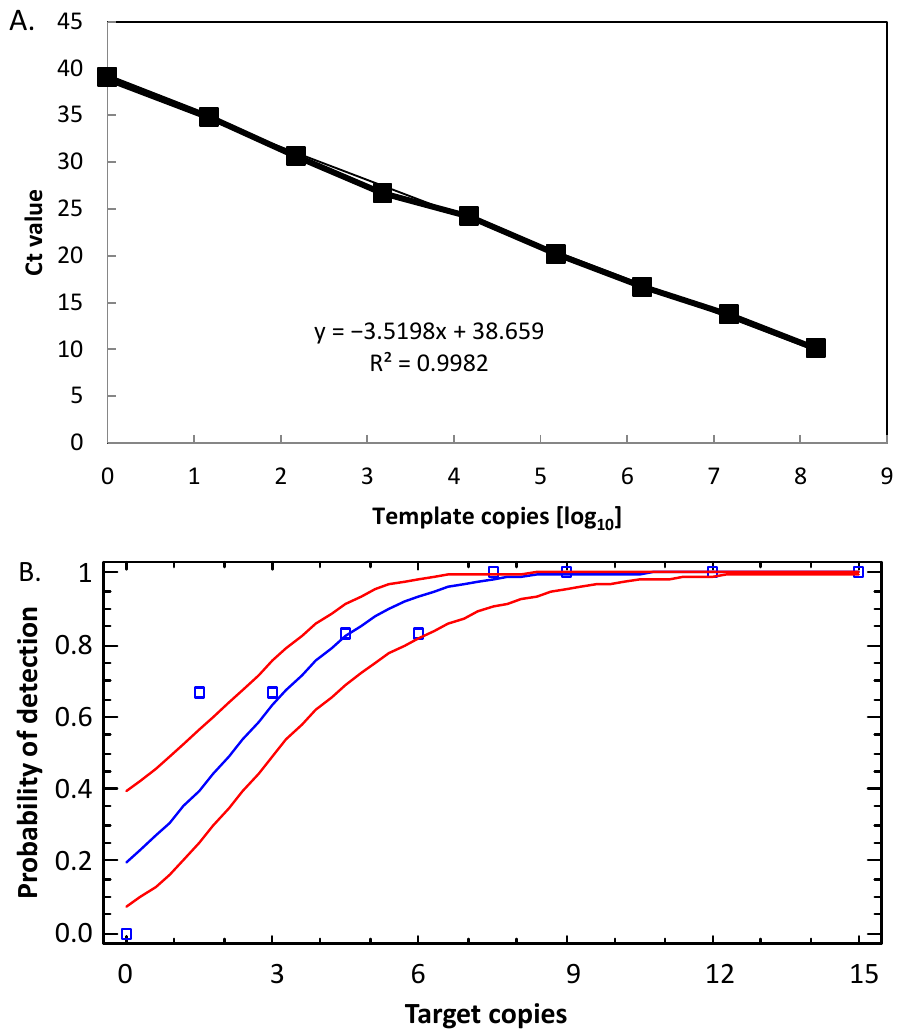
Figure 5. Linearity and LoD of the 16S rRNA SNP RT-PCR. Serial dilutions of RNA (with DNA) of B. anthracis strain Sterne were serially diluted 1:10, RT-PCR-tested and template copies plotted against Ct values ( A ). Indicated in the graph is the slope of the linear regression and the coefficients of determination (R 2 ). Individual data points represent average values from n = 3 × 3 PCR-tests. Analytical sensitivity of the 16S rRNA SNP RT-PCR was determined by diluting samples from ( A ) to the indicated copies per reaction (numerical data in Table S16) and subjected to RT-PCR (12 replicates for each data point). To determine the LoD, probit analysis (plot of fitted model, blue squares, and line) was performed (as in Figure 2), and the lower and upper 95% confidence limits (red lines) were determined ( B ).